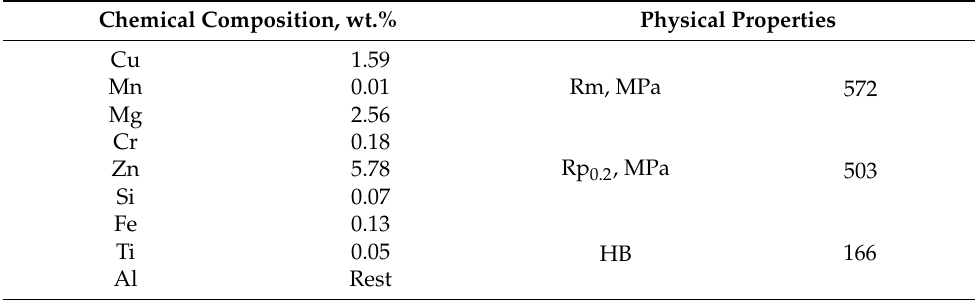
Table 4. Chemical composition and physical properties of EN AW 7075 aluminum alloy.